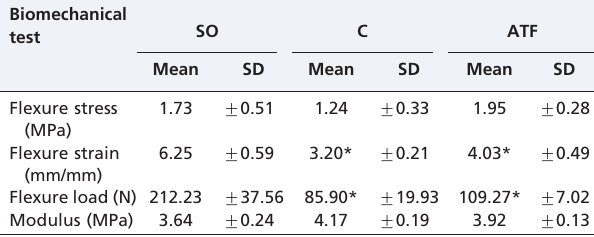
Table 3 - The stress, strain, load, and Young’s modulus parameter derived from the bone biomechanical testing. Biomechanical